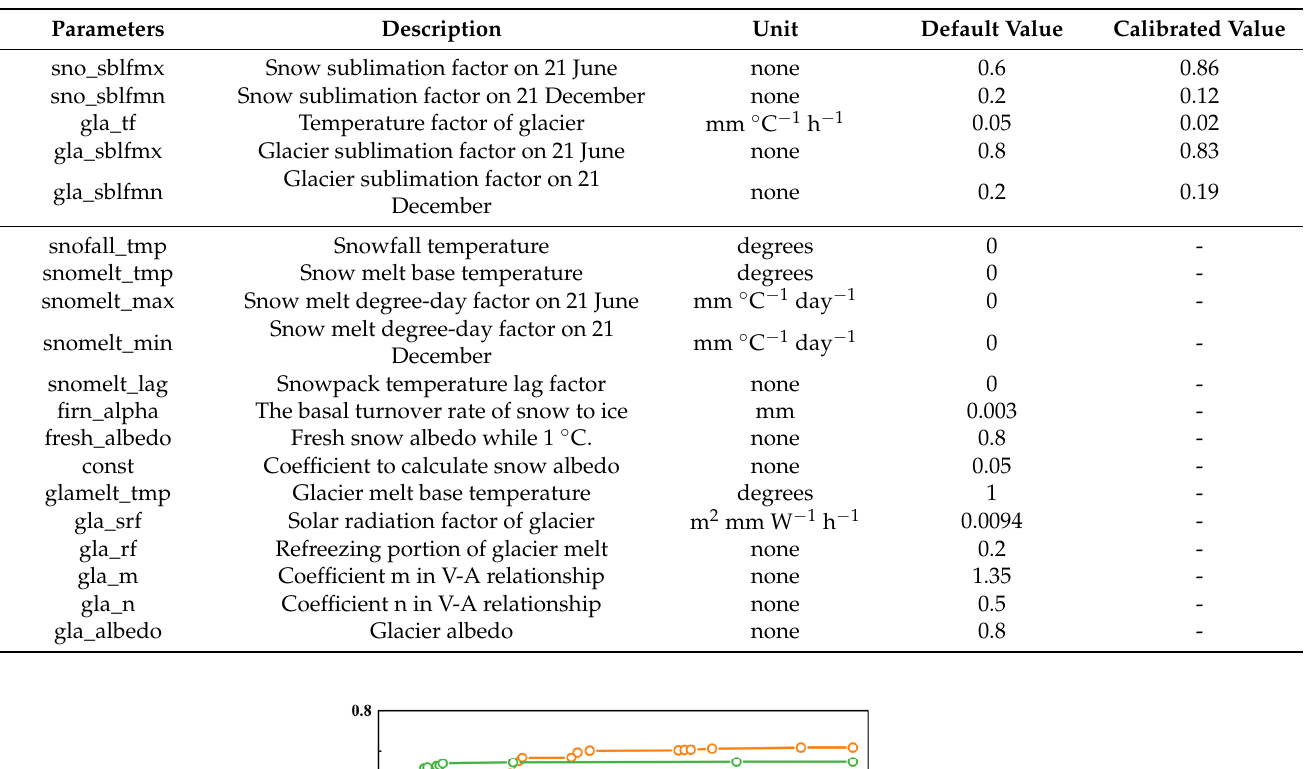
Table 2. Values of parameters related to glacier and snow processes.